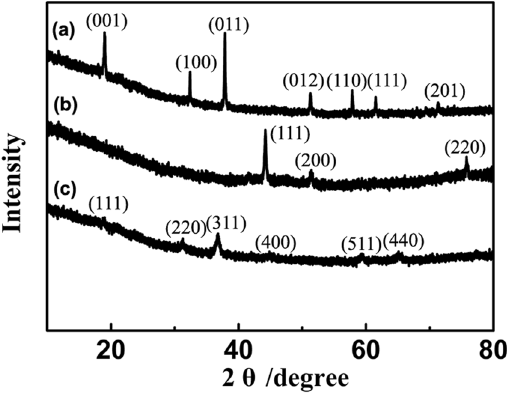
Figure 2. XRD patterns of the hybrid films: ( a ) Co(OH) 2 /GO, ( b ) Co/GS, ( c ) Co 3 O 4 /GS hybrid films.